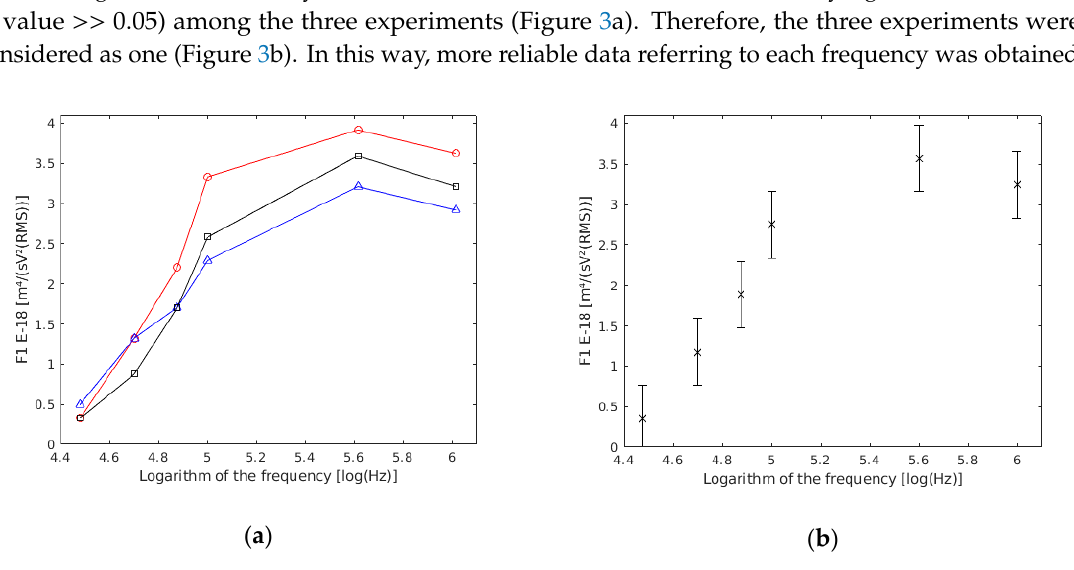
Figure 3. ( a ) 𝐹 (cid:2869) results based on frequency obtained in each of the experiments conducted with single yeast cells. ( b ) Results of the three experiments together.